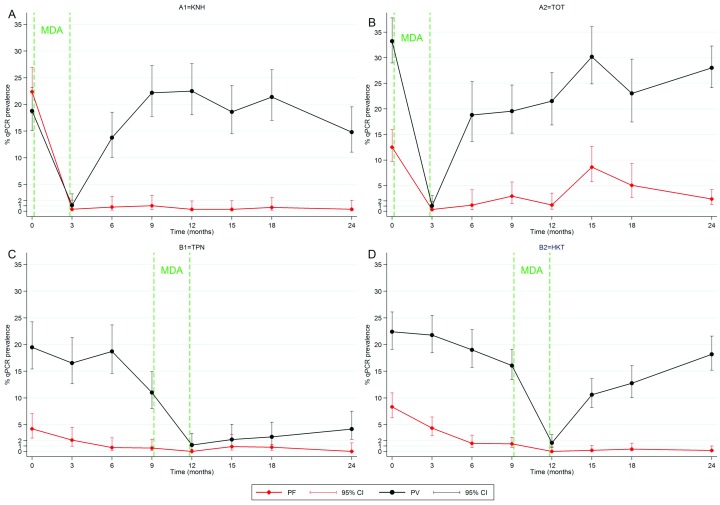
Prevalence of
P. falciparum and
P. vivax carriage over 24 months measured by uPCR in quarterly cross sectional surveys conducted in the four study villages.A steep decrease in prevalence immediately followed MDA in all 4 villages. The reduction in
P. falciparum prevalence was sustained in 3 of 4 villages stabilizing to a <1% prevalence after MDA. In contrast
P. vivax prevalence rebounded in 3 of 4 villages. In village A2-TOT,
P. falciparum prevalence increased at M15 and M18, mostly from clinical cases occurring while vector densities and thus transmission was increased (
Table 5). A decrease in
P. falciparum prevalence was observed in the control period (M0–M9) in villages B1 and B2, possibly attributable to the effect of early diagnosis and treatment provided by MP.